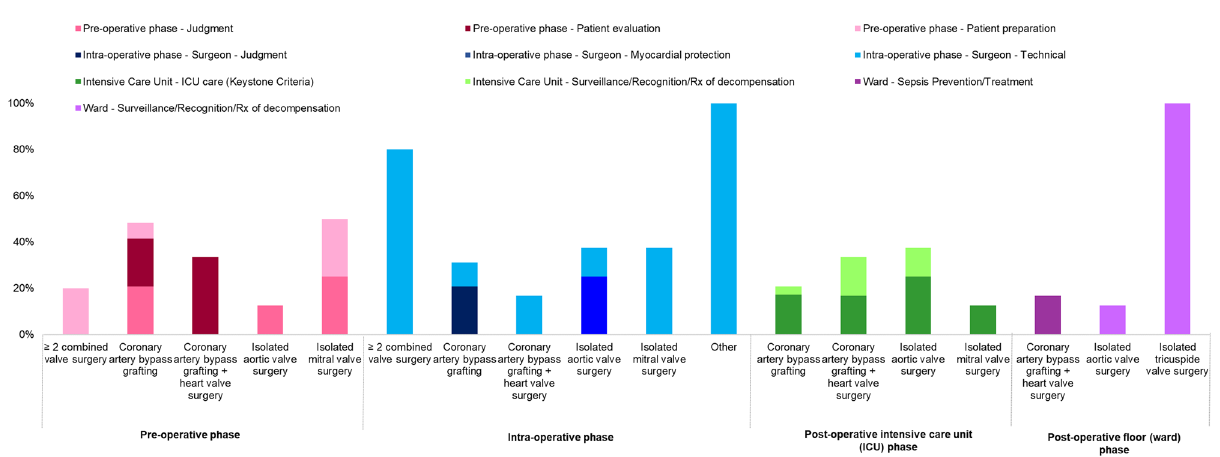
Figure 3. Phase of care mortality analysis comparison between surgery populations. Association between perioperative care phase SE and surgical